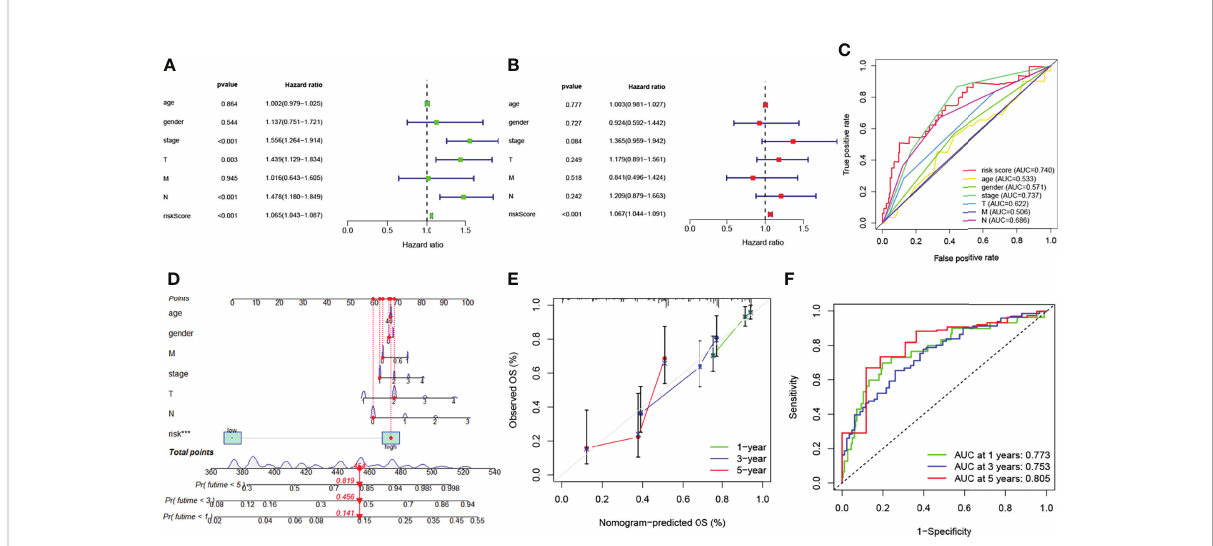
FIGURE 5 Prognosis value of model lncRNAs in lung adenocarcinoma (LUAD). (A) Univariate analysis of various clinical features and risk score. (B) Multivariate analysis of various clinical features and risk score. (C) ROC curves of the risk model (risk score: AUC = 0.740). (D) A nomogram was performed to predict the 1-, 3-, and 5-year survival. (E) Calibration curve of the nomogram model. (F) The results of ROC curves in predicting the LUAD survival rates. ROC, receiver operator characteristic; AUC, area under the